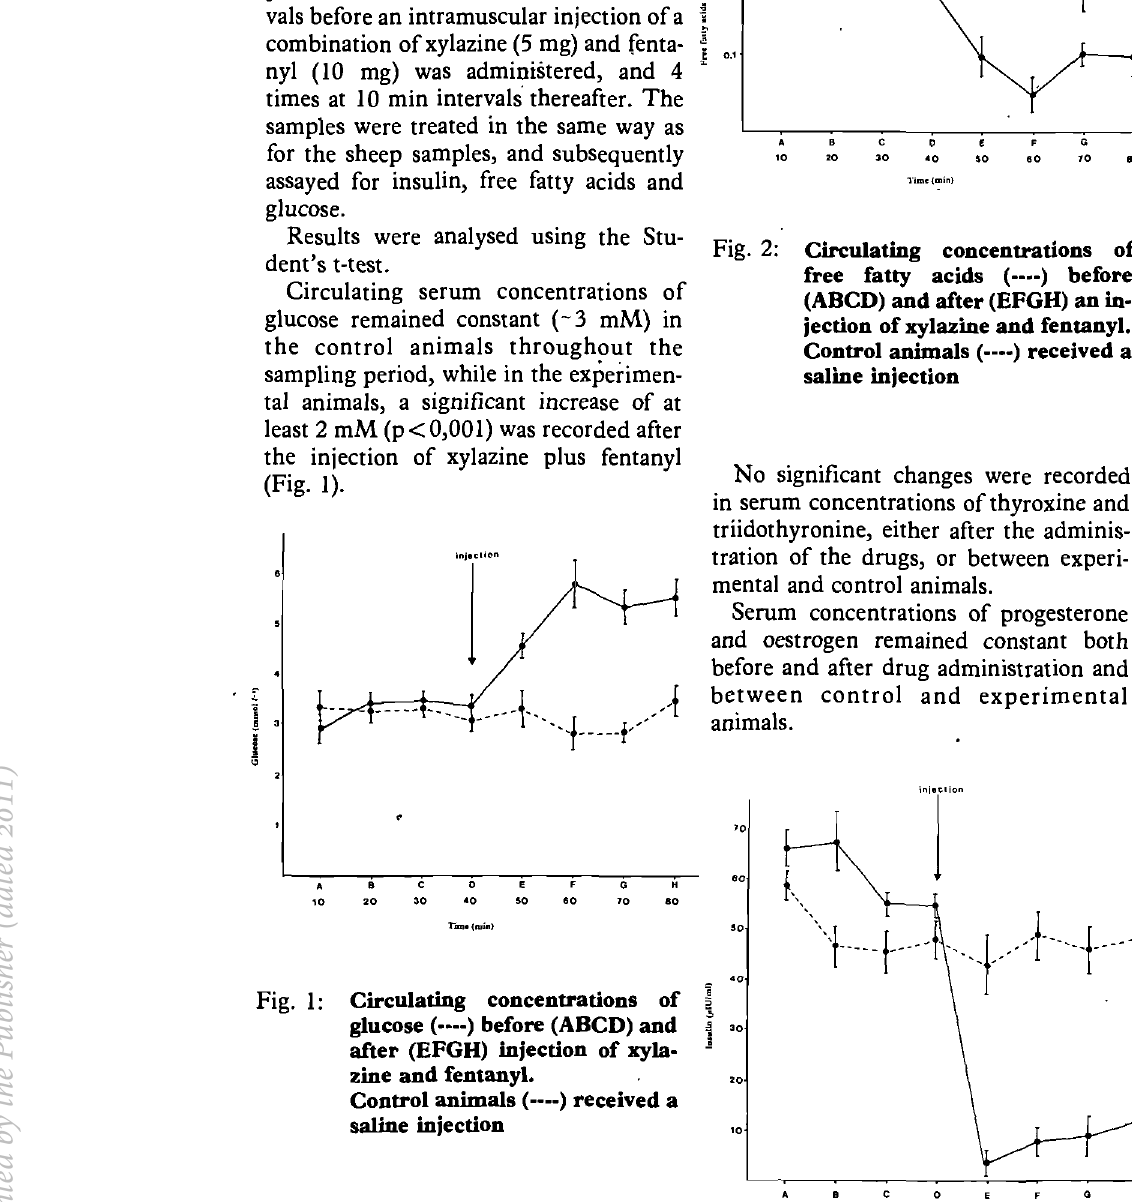
60 4_ Clarke I J, DoughlOn B W 1983 Effect of various anaesthetics on resting plasma concen trations of luteinising hormone, follicle-stimu lating hormone and prolactin in ovarieclOmised ewes. Journal of Endocrinology 98: 79-89 Circulating concentrations of in·